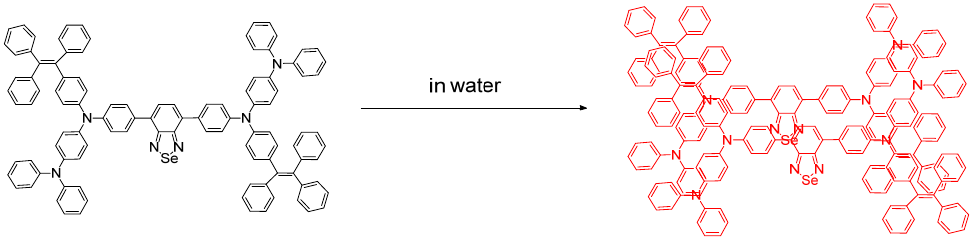
Figure 71. The aggregation-induced fluorescence achieved with a recent probe by Qin et al.